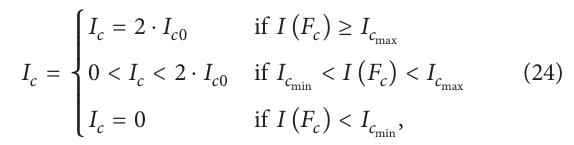
For multiple faults, that is, faults in two or three dampers of the vehicle, two aspects must be